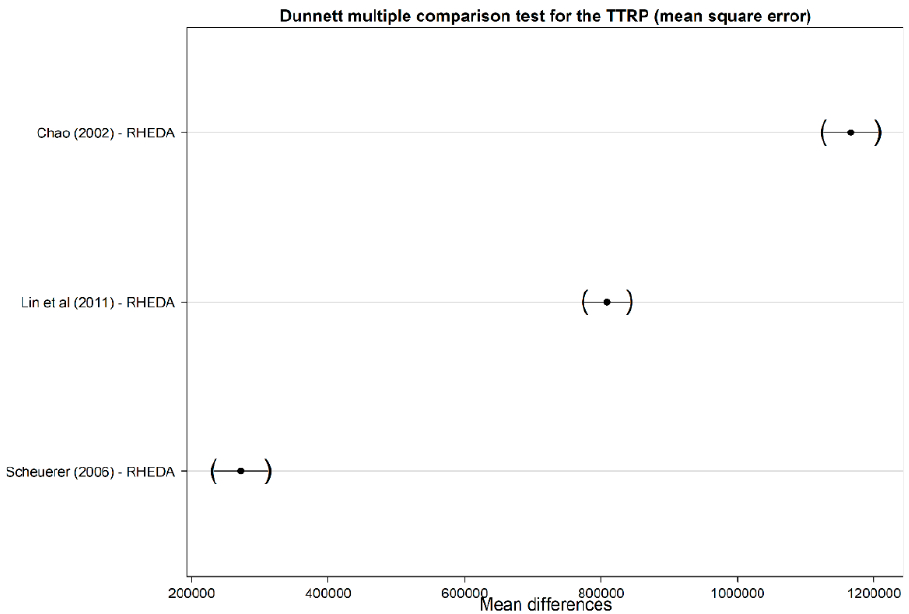
Figure 8. Dunnett test for the TTRP using the mean square error.